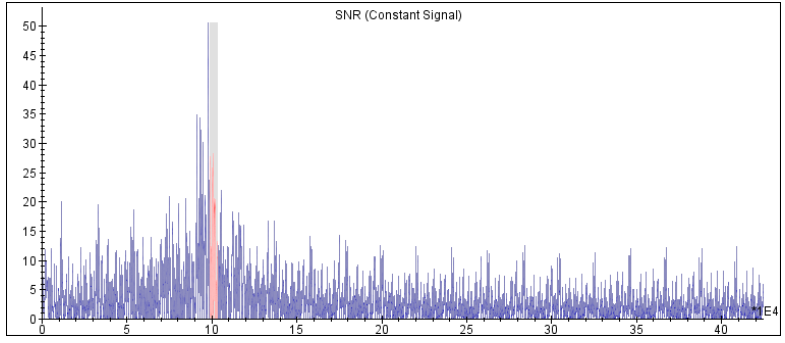
Figure 6: SNR for the unprotected implementation with fixed input and